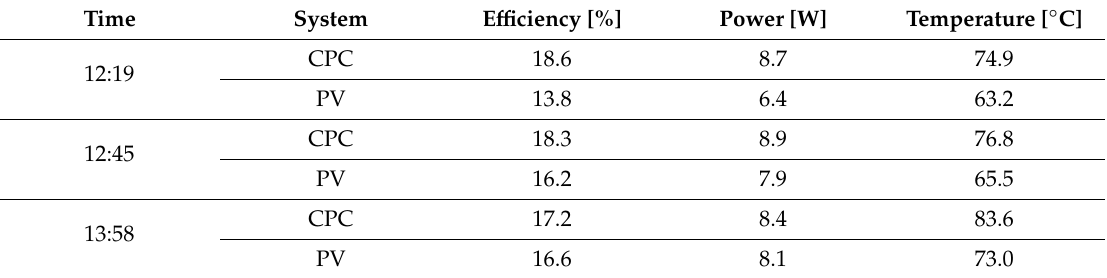
Table 2. Maximum values on 17 July 2017 for photovoltaic (PV) and CPC configurations